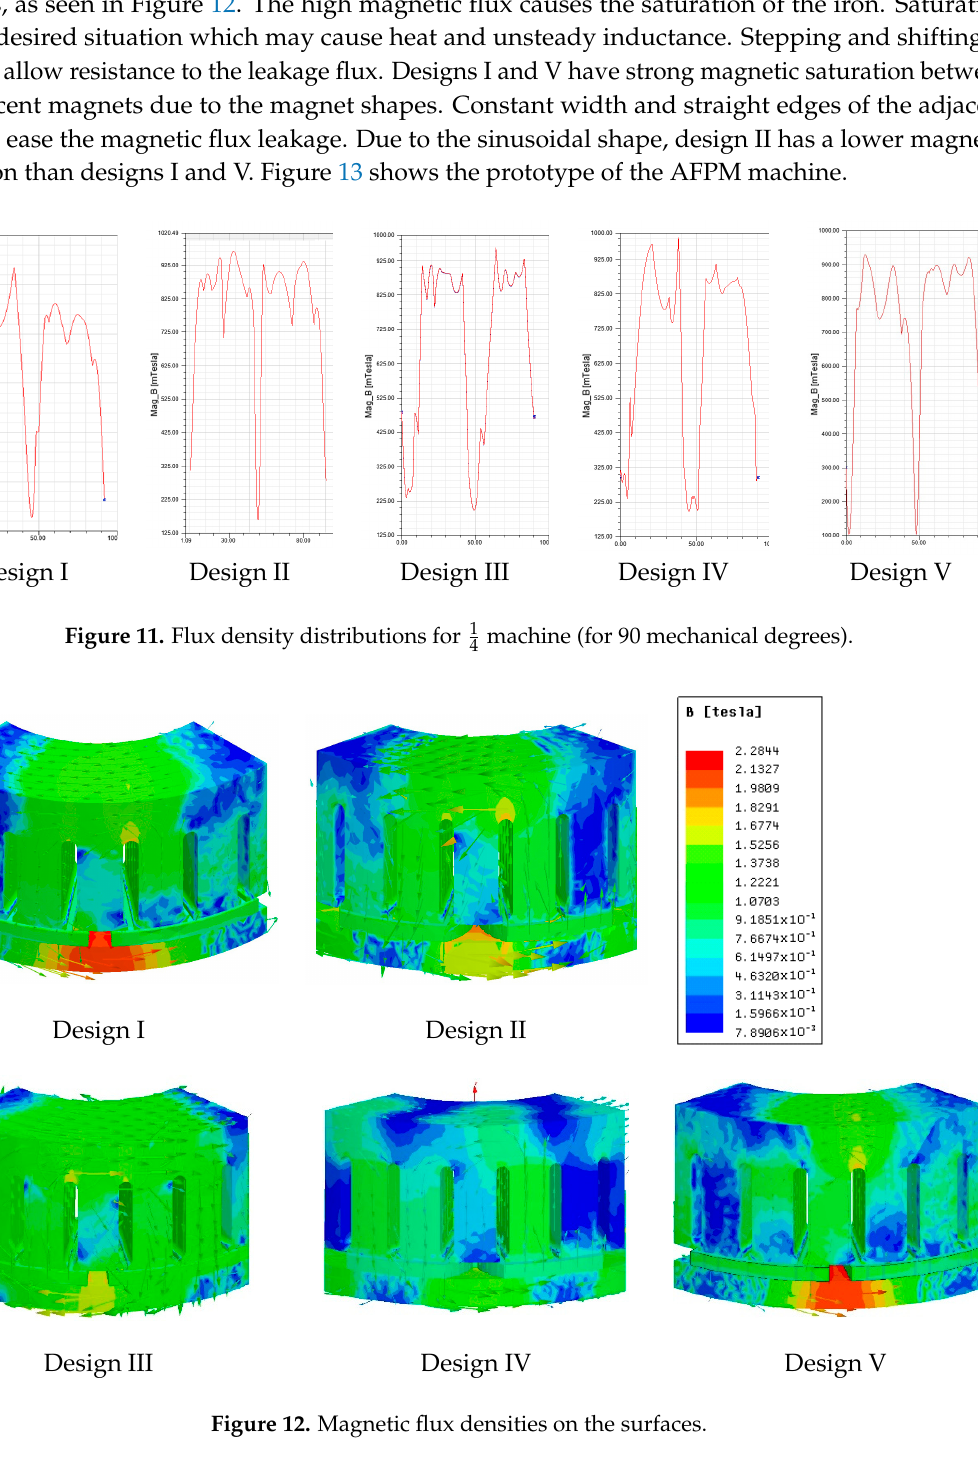
Figure 12. Magnetic flux densities on the surfaces.